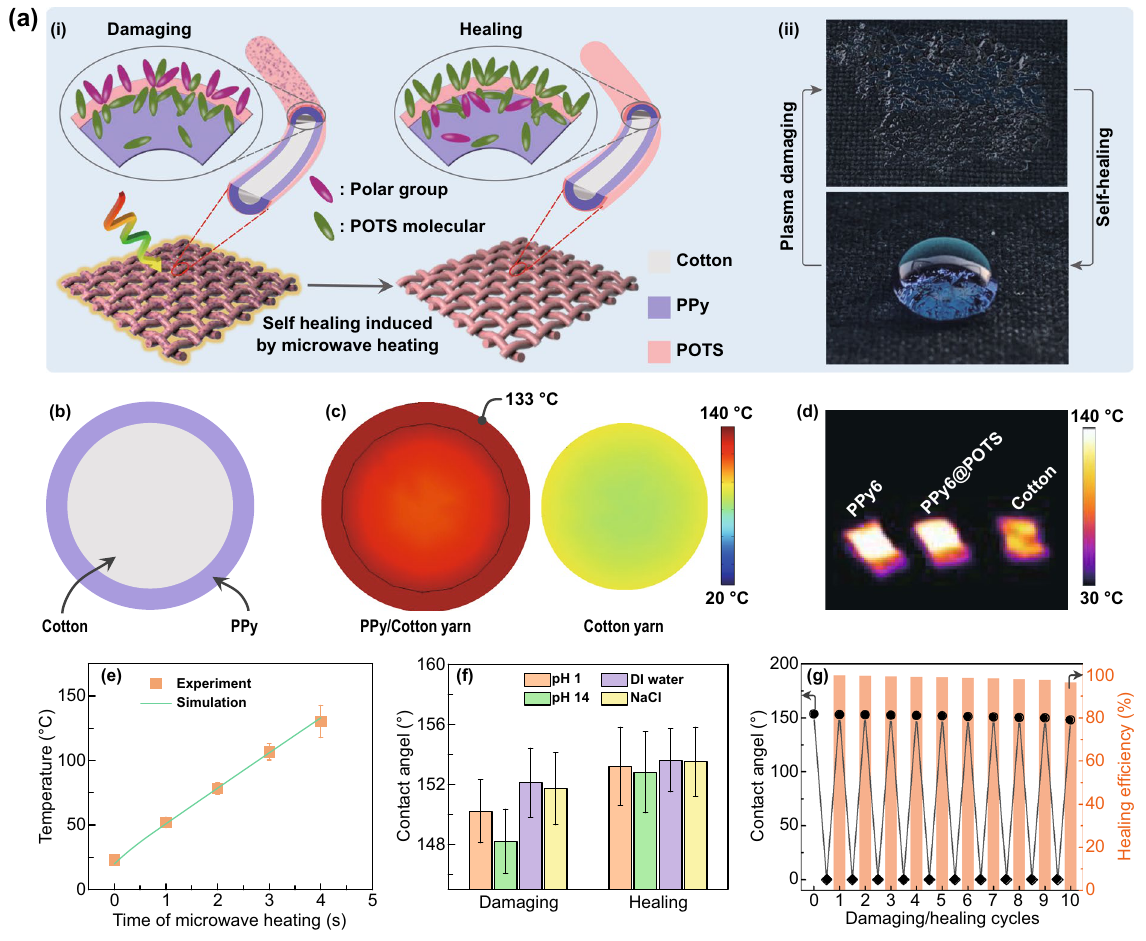
Fig. 5 Near-instantaneous self-healing of PPy n @POTS fabrics via microwave heating. a Schematic of the POTS self-healing mechanism on a PPy n @POTS fabric (i) and the instant recovered water contact angle after plasma damage and self-healing via microwave heating (ii). b Cross- sectional geometry of a simplified PPy/cotton yarn model. c Simulated temperature profiles of a PPy/cotton yarn and bare cotton yarn after 4 s of microwave heating. d Infrared thermal image of raw, PPy6, and PPy6@POTS fabrics after microwave heating for 4 s. e Surface temperature plot of both experimental and simulated results. f Water contact angle of PPy6@POTS fabrics after damage by 96 h of immersion in different solutions and the corresponding healed water contact angle by microwave heating. g Water contact angle and healing efficiency of